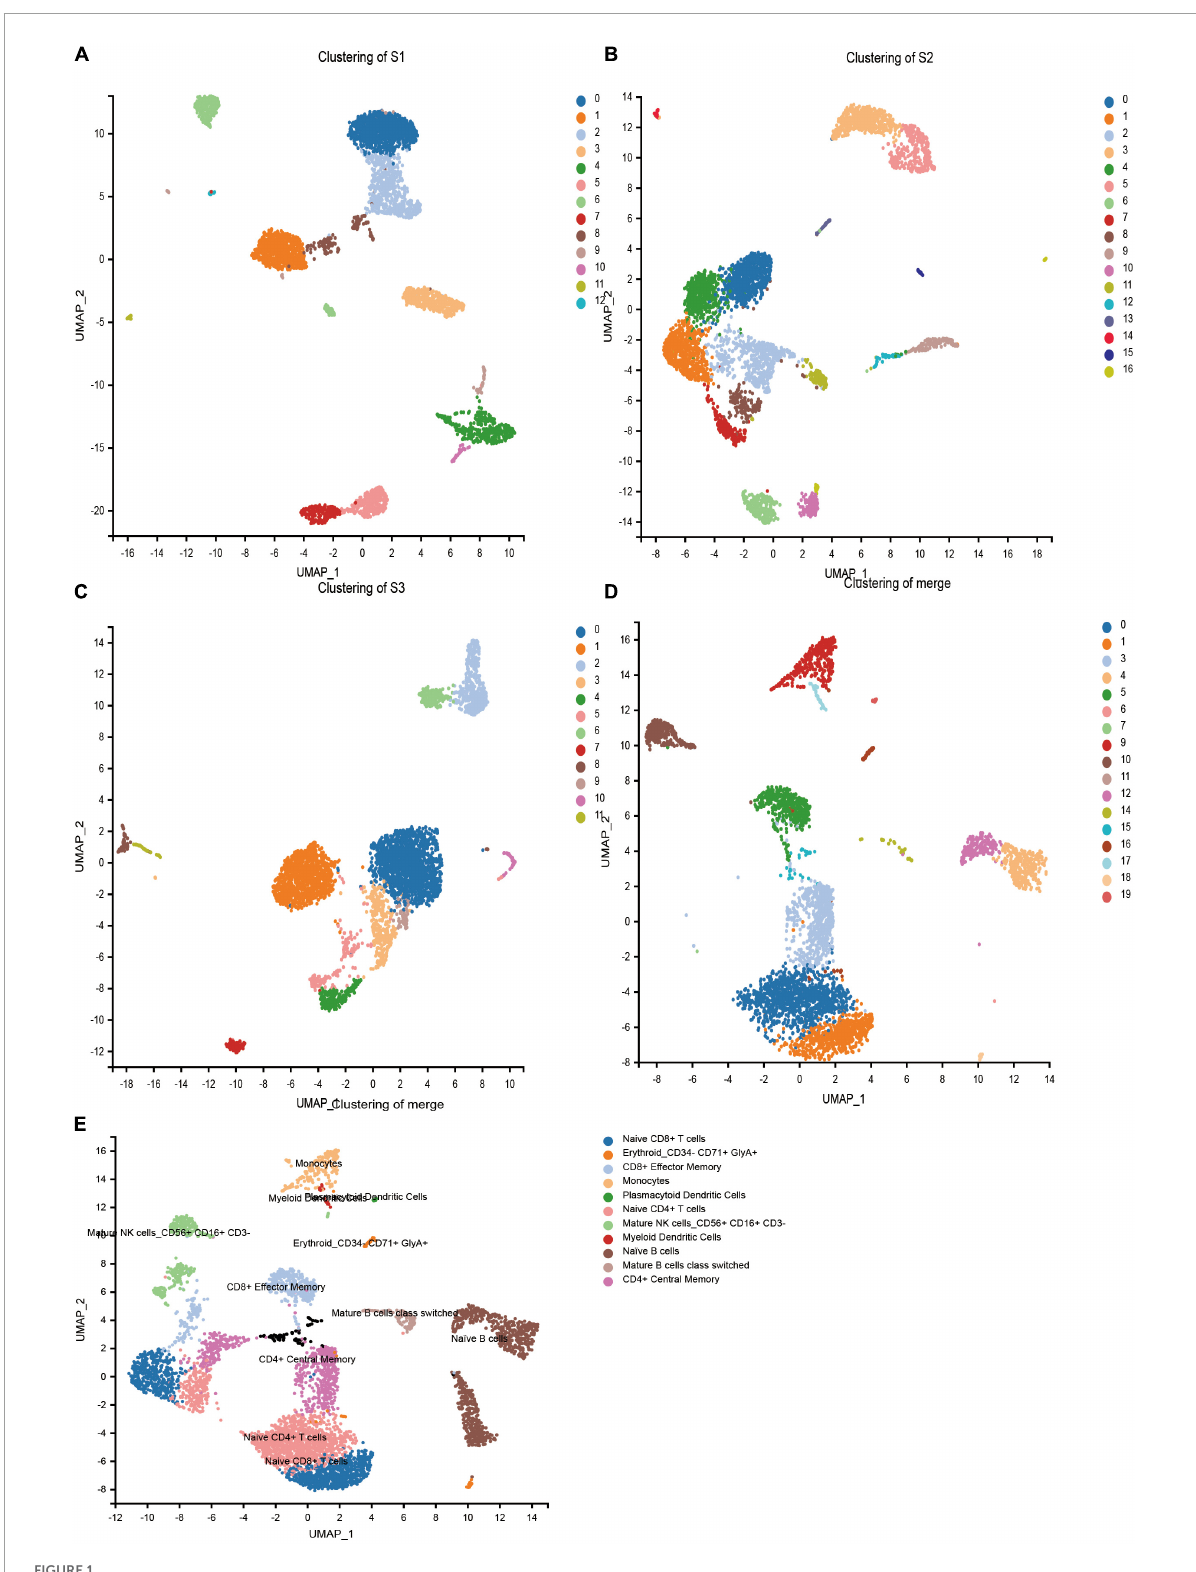
FIGURE1 Cell types identified in peripheral blood mononuclear cells (PBMCs) by uniform manifold approximation and projection (UMAP). (A) 13 cell clusters in S1 ( n = 9,014). (B) 17 cell clusters in S2 ( n = 8,178). (C) 12 cell clusters in S3 ( n = 8,615). (D) 20 cell clusters in three samples merged ( n = 25,807). (E) 20 cell clusters in three samples ( n = 25,807), eleven cell types were